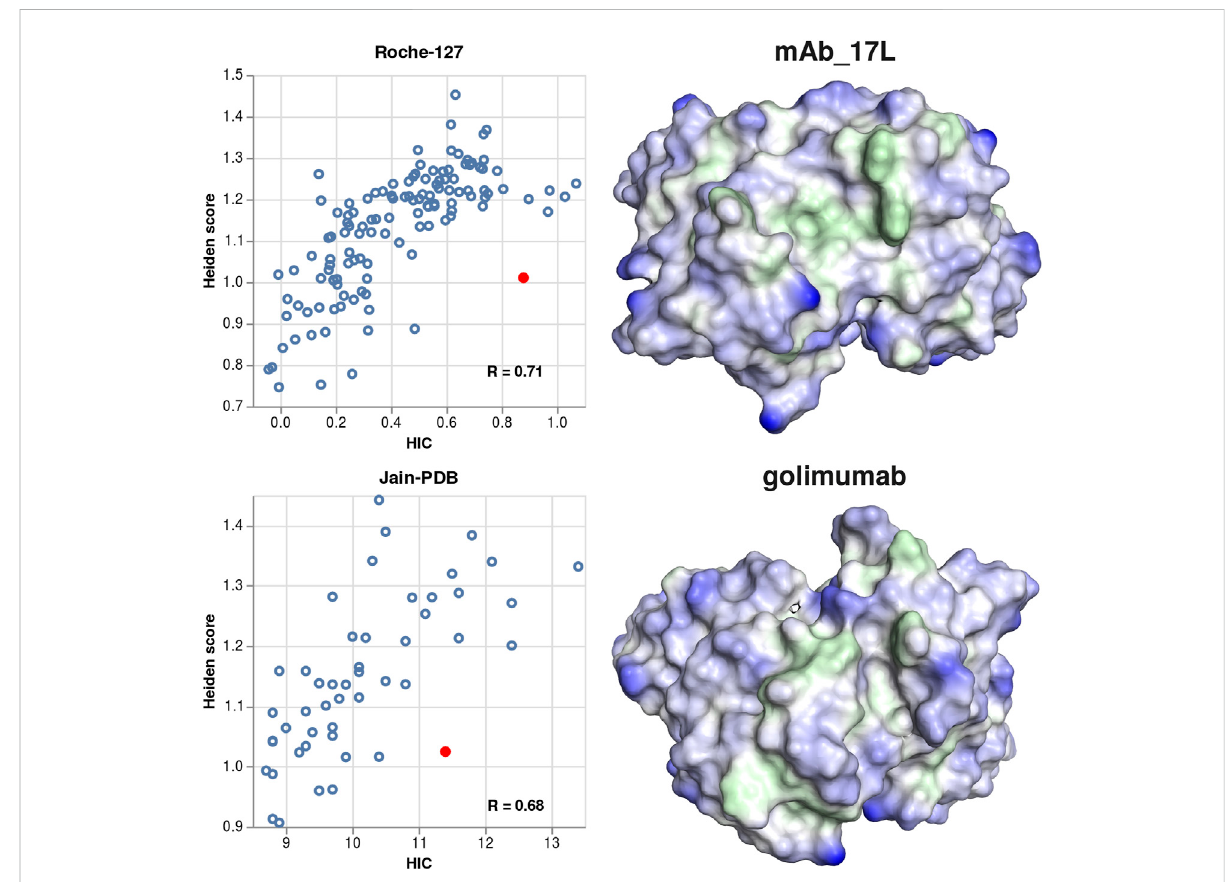
FIGURE 7 Examplesforstructureswheretheexperimentalhydrophobicityisunder-predictedbytheHeidenscore.Leftcolumn:scatterplotsshowingthe Heiden score vs. the experimental HIC values, for the Roche-127 set (top) and the Jain-PDB set (bottom). In each plot, one antibody is marked, and therespectivesurfaceisshownattherightside.Greensurfacecorrespondstohydrophobicregions(Heidenscore > 0)andbluesurfacecorresponds to hydrophilic regions (Heiden score <